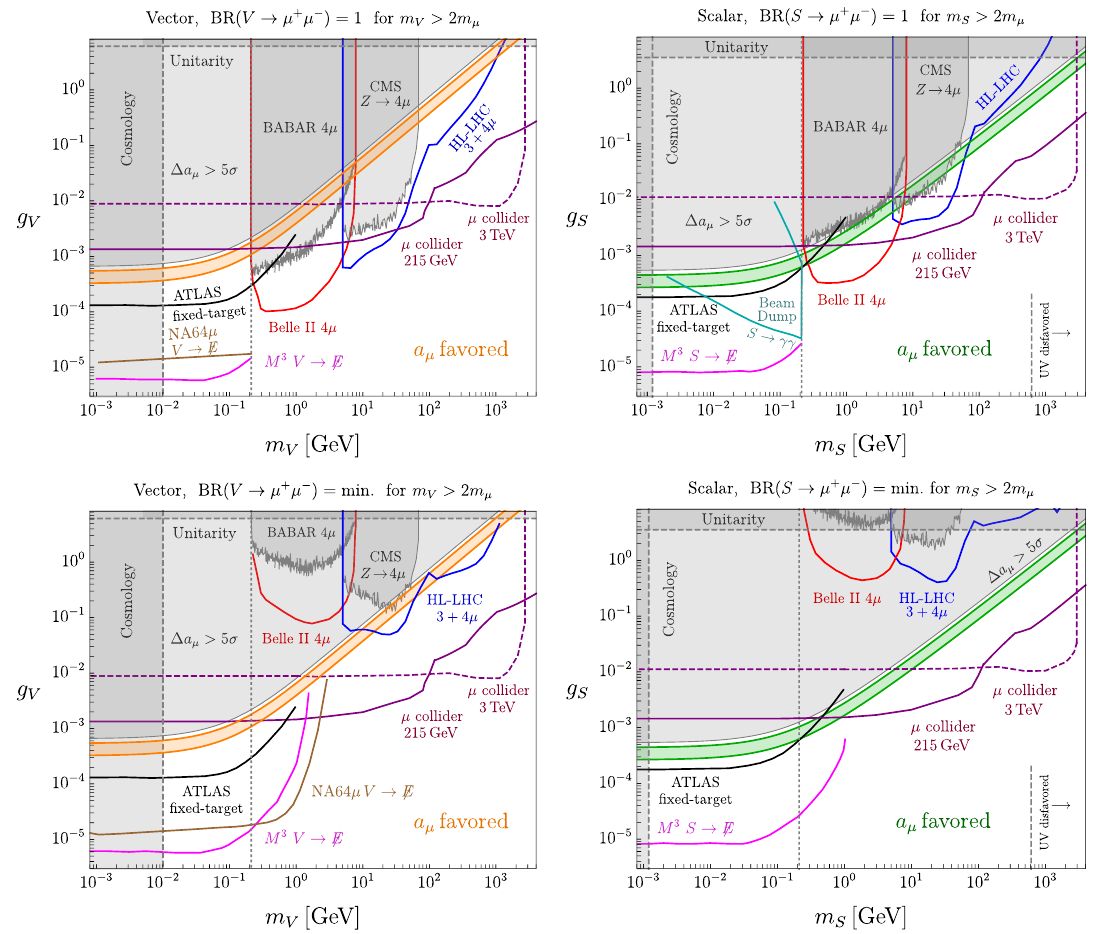
Figure 3 . Top: limits and projections on muon-philic vector (left) and scalar (right) singlets, assuming only di-muon decays where kinematically allowed. The green/orange bands represent the parameter space that resolves ( g − 2) . Existing experimental limits are shaded in gray (Supernova µ constraints, not shown, can probe scalar masses up to 20 MeV and couplings up to 4 × 10 − 3